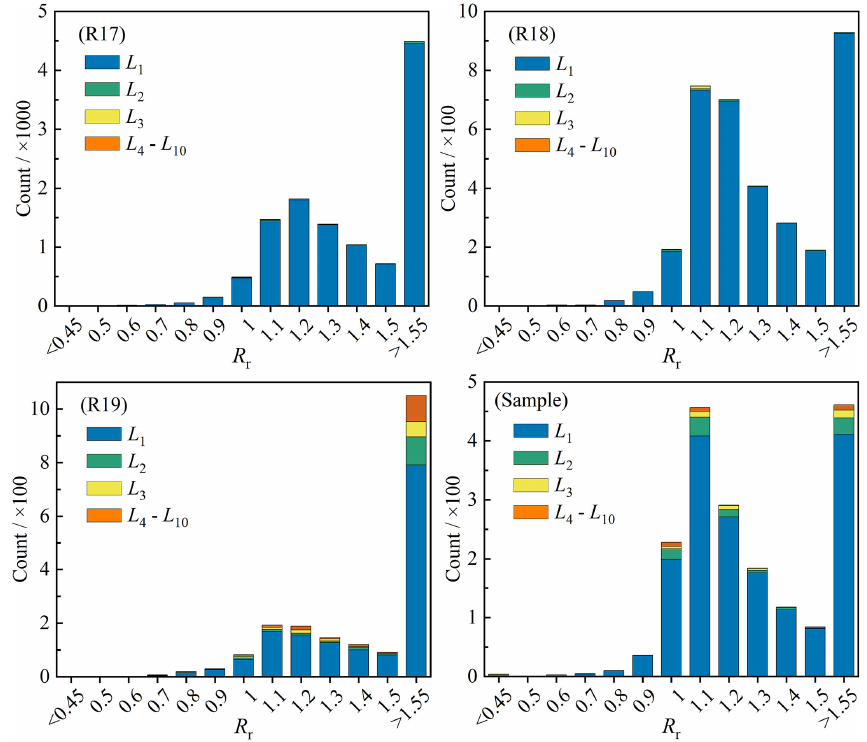
Figure B2. Histograms of the length ratio ( R r ; G Lmax /L max ) of distinct glacier grades in glacier-covered regions and all samples.